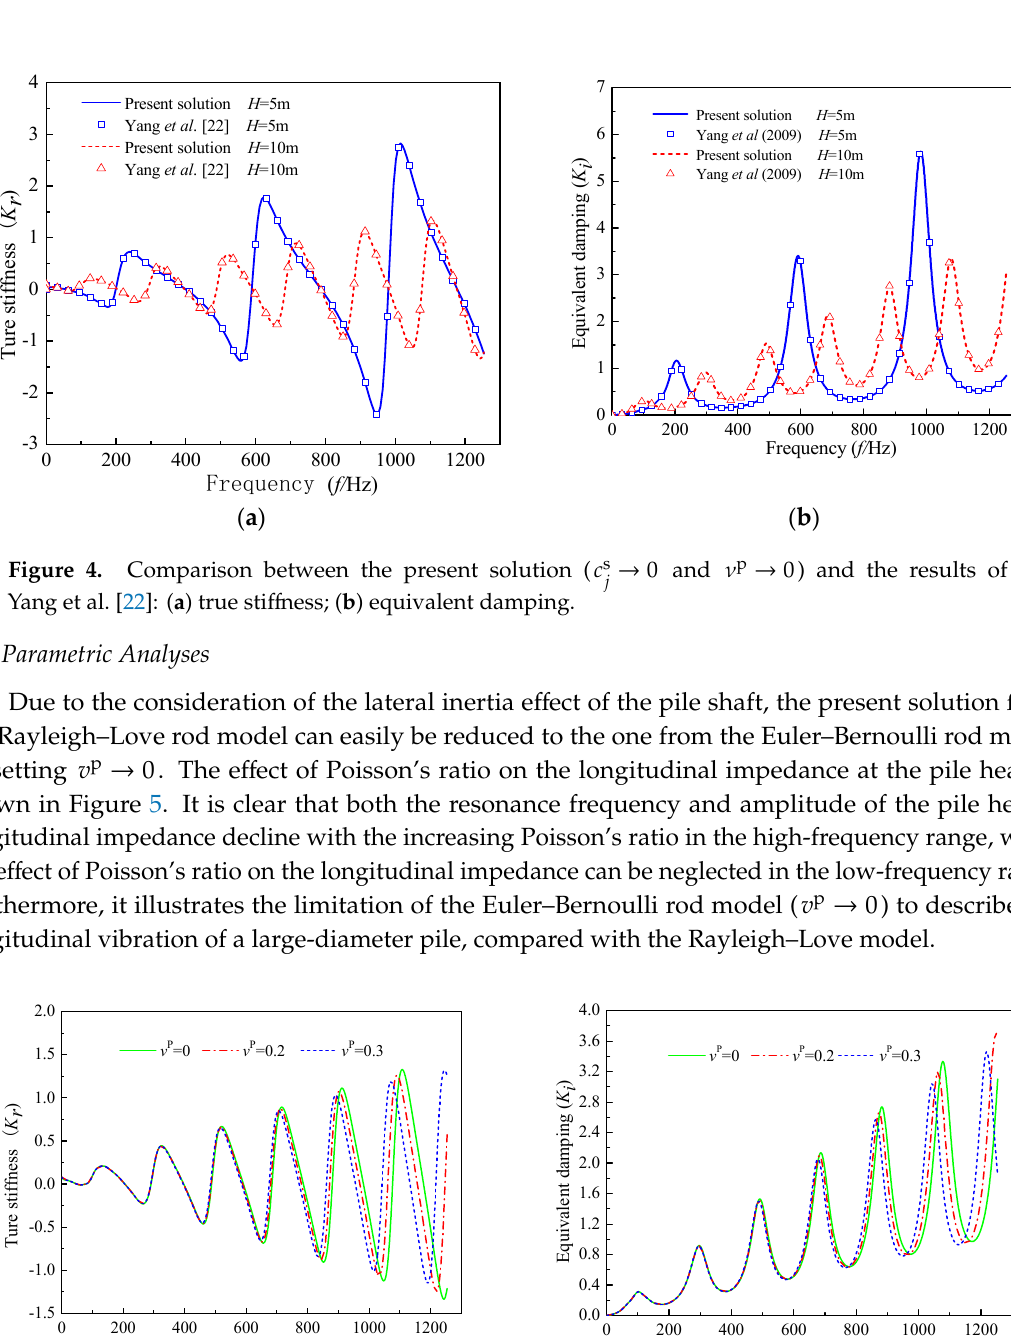
s →ζ ) and the solution of Lü et al. [29]: ( a )